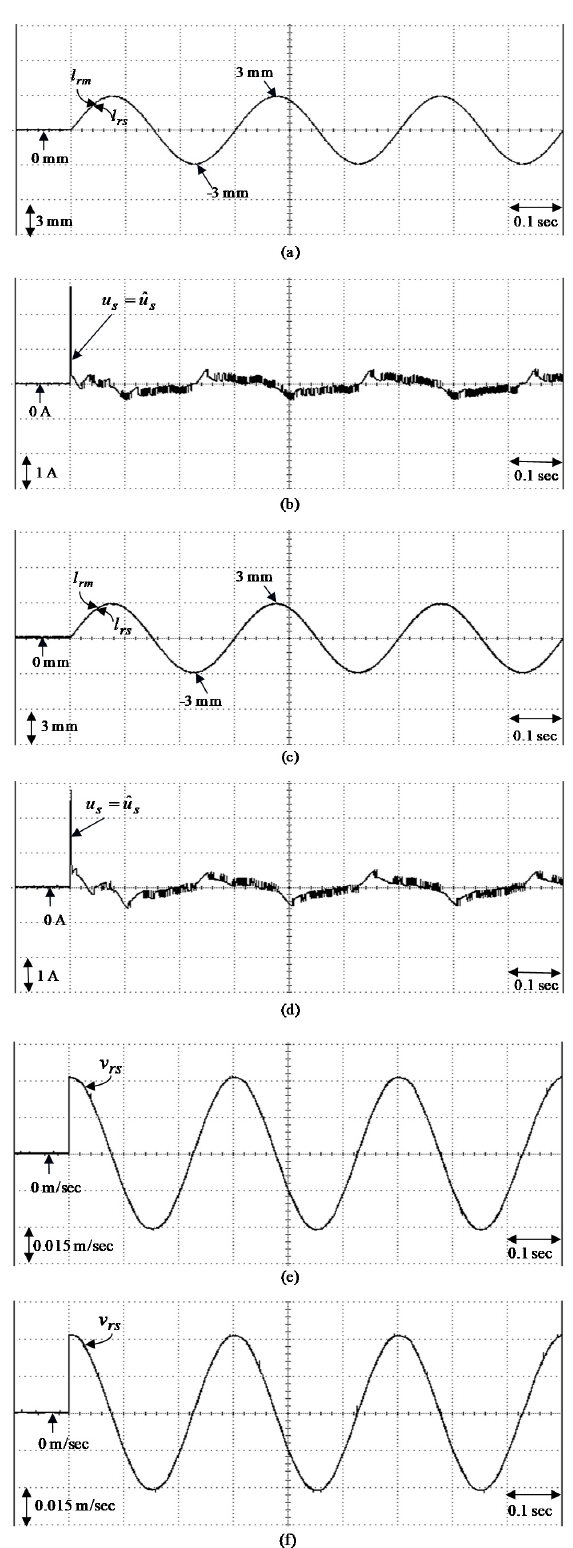
Figure 13. Tested results utilized by the control system K3: ( a ) mover position response at Situation Q3, ( b ) control propulsion response at Situation Q3, ( c ) mover position response at Situation Q4, ( d ) control propulsion response at Situation Q4, ( e ) mover velocity response at Situation Q3, ( f ) mover velocity response at Situation Q4.